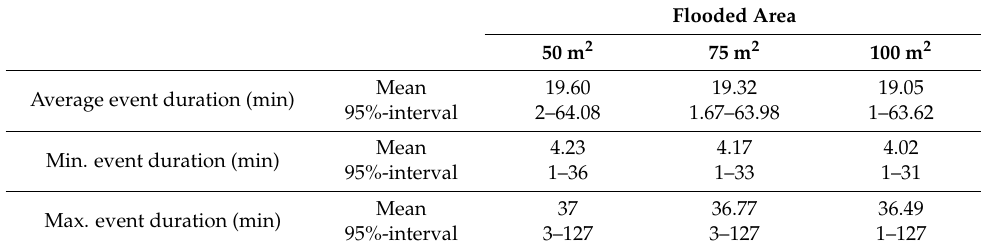
Table 2. Summary statistics of duration (in minutes) of flooding events in the ‘Tuindorp’ catchment.